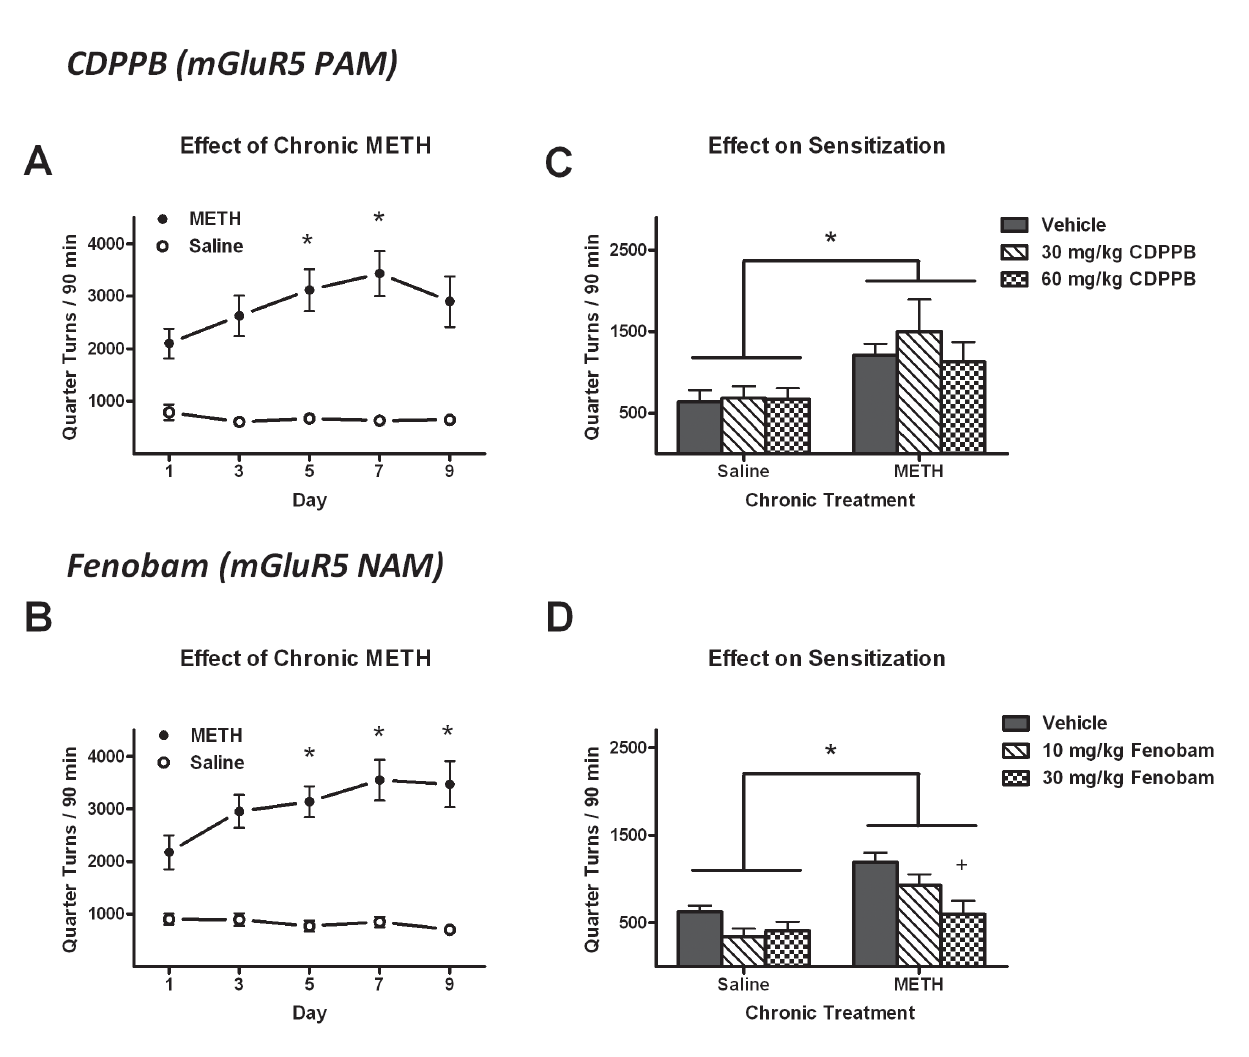
Figure 2. Effects of mGluR5 treatment by CDPPB (top row) or fenobam (bottom row) on locomotion and methamphetamine (METH) behavioral sensitization. In locomotor sessions prior to mGluR5-targeted treatment ( A - B ), rats were chronically given 1 mg/kg METH (filled circles) or saline (open circles). In both the CDPPB ( A ) and fenobam ( B ) experiments, the reported quarter turns progressively increased above first-day levels in the METH-exposed groups. * P < 0.05 different from Day 1 levels. In the subsequent test using 0.5 mg/kg METH in all groups ( C ), rats with a history of chronic METH exposure exhibited elevated locomotor behavior, but CDPPB pretreatment had no effect. In the fenobam experiment ( D ), rats with a history of chronic METH exposure also exhibited elevated locomotor activity, and this behavioral sensitization was not affected by 10 mg/kg fenobam pretreatment. After 30 mg/kg fenobam treatment, the METH-sensitized locomotor response was reduced from the vehicle level. * P < 0.05 difference between METH history groups, regardless of mGluR5 ligand treatment. + P < 0.05 different from vehicle treated group with matching history of METH exposure. PAM stands for positive allosteric modulation, and NAM stands for negative allosteric